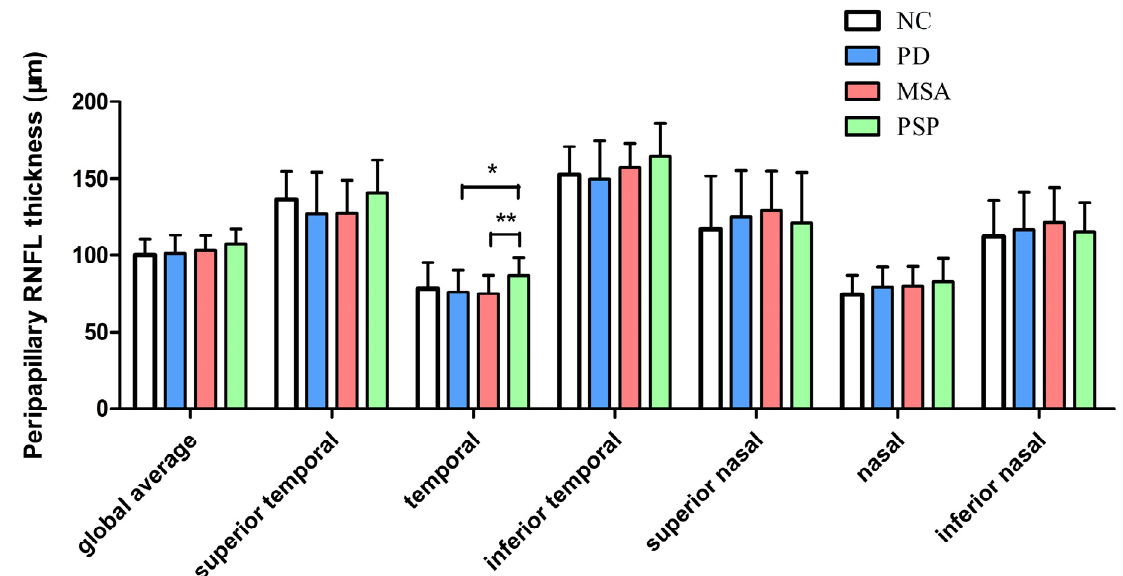
Figure 1. Peripapillary retinal nerve fiber layer thickness in patients with PD, MSA, PSP, and controls. * p ≤ 0.05, ** p ≤ 0.01. The error bar describes standard deviations (SD). Abbreviations: PD, Parkinson’s disease; MSA, multiple system atrophy; PSP, progressive supranuclear palsy. ROC analysis for discriminating MSA from PSP found that the area under the curve (AUC) was 0.825 (95%CI 0.713–0.936, p < 0.001, sensitivity 83.3%, specificity 81.5%) for pRNFL thickness in the temporal sector, after controlling for age, sex ratio, and disease duration. The AUC for discriminating PD from PSP was 0.892 (95%CI 0.808–0.977, p < 0.001, sensitivity 77.8%, specificity 89.6%) for pRNFL thickness in the temporal sector, after controlling for age, sex ratio, and disease duration.